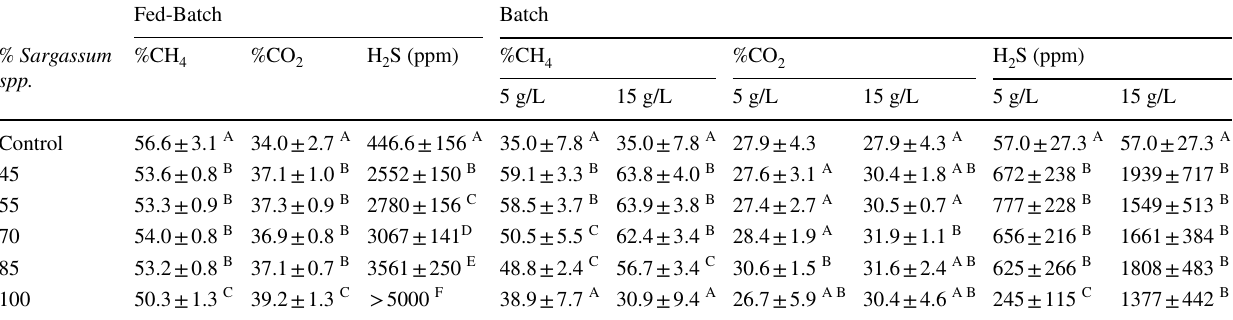
A,B,C,D,E Different letters within each column indicate a significant difference between experimental units for the unpaired t test (alpha =